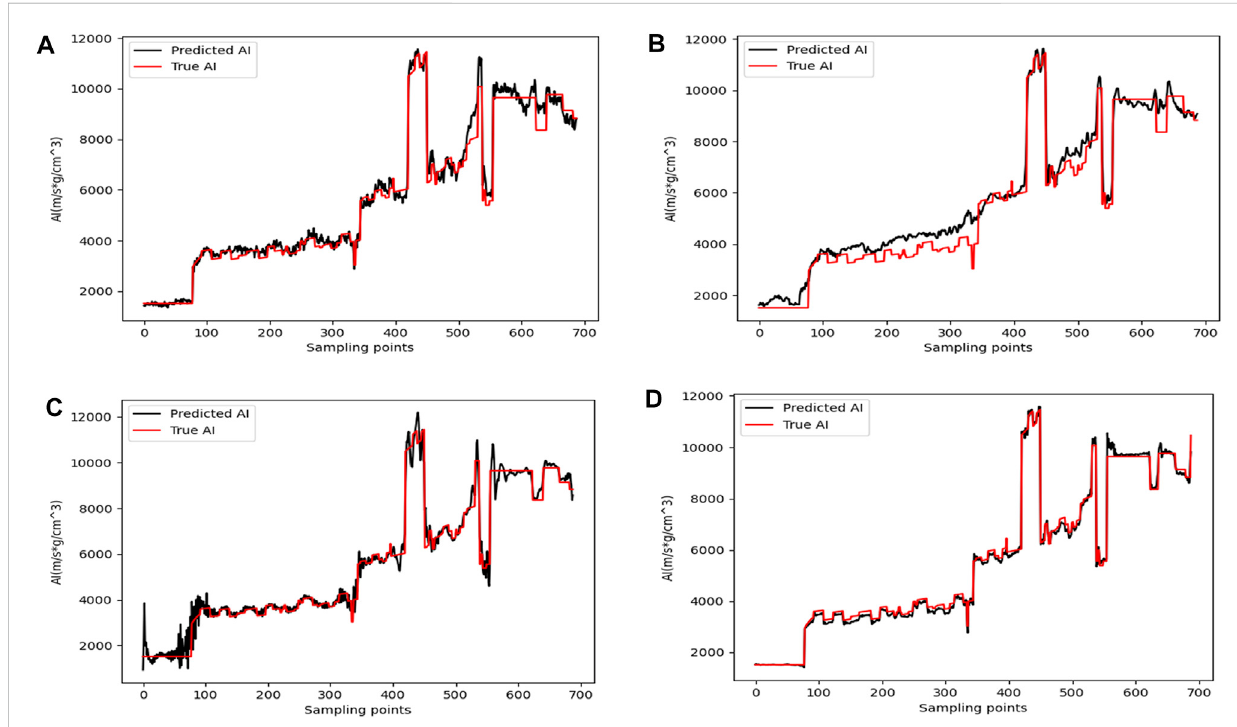
FIGURE 7 Acoustic impedance inversion results of trace no. 570. (A) Inversion result of the CNN method. (B) Inversion result of the TCN method. (C) Inversion result of the 1D U-Net method. (D) Inversion result of the method in this